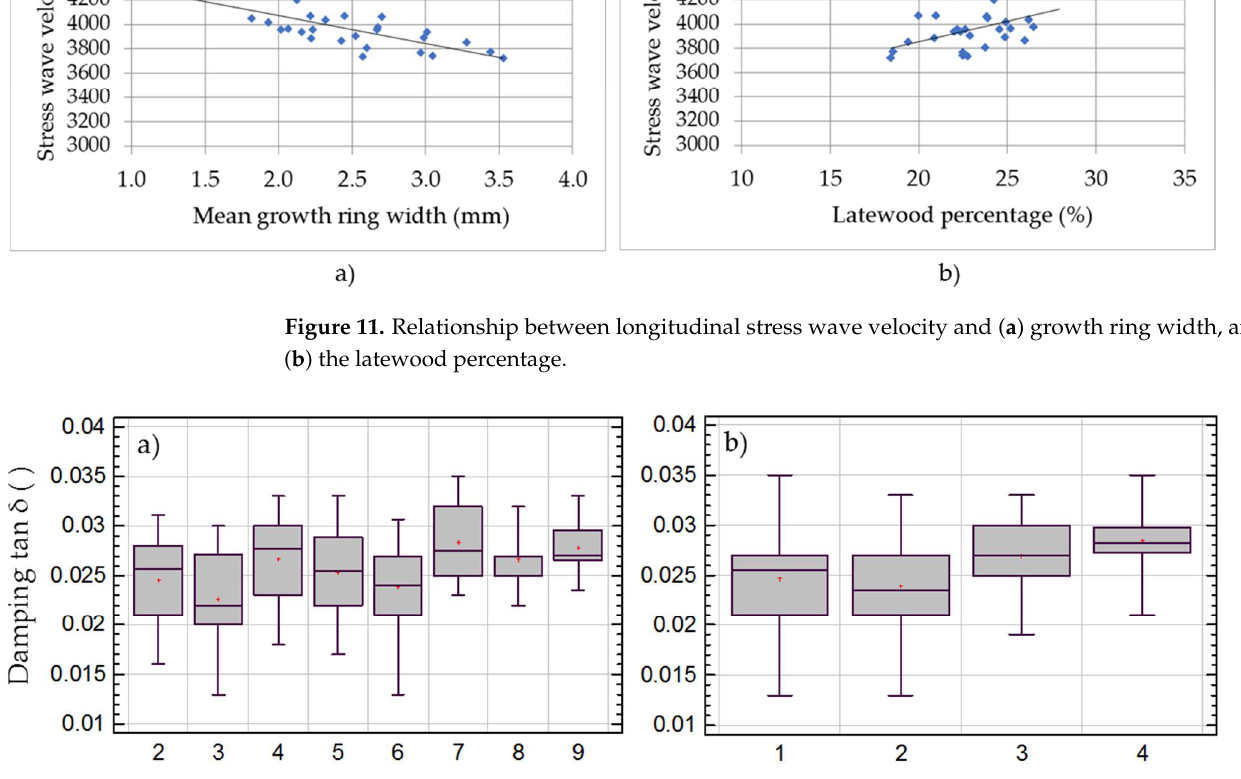
Figure 11. Relationship between longitudinal stress wave velocity and ( a ) growth ring width, and ( b ) the latewood percentage.